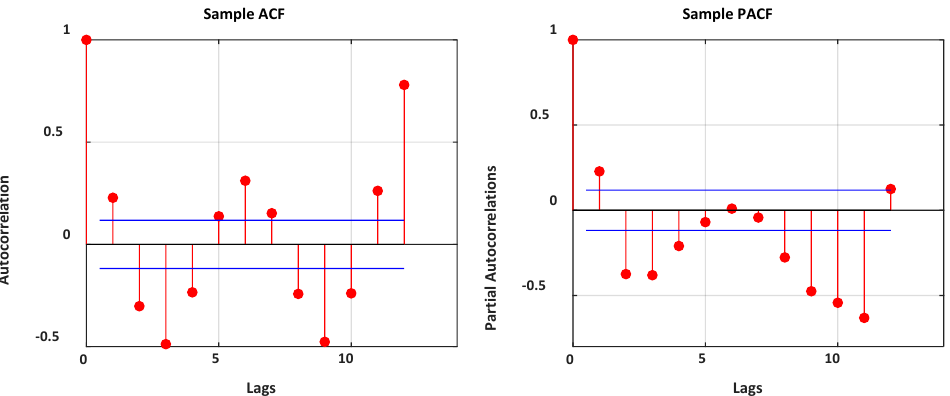
Figure 4. Sample autocorrelation function (ACF) and partial autocorrelation function (PACF) plot of differenced time-series. Table 1. Detailed statistics of load time-series.